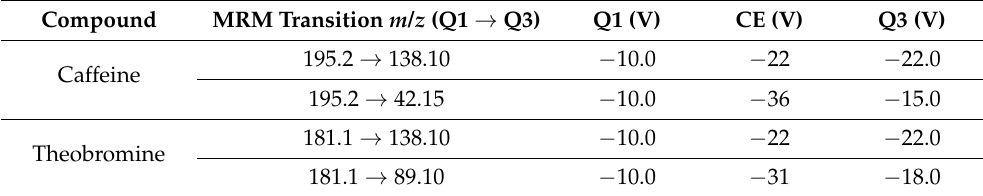
Table 1. Multiple reaction monitoring (MRM) transitions and mass spectrometric conditions used for the identification of caffeine and theobromine isolated from I. paraguariensis and various cultivars of I. aquifolium .